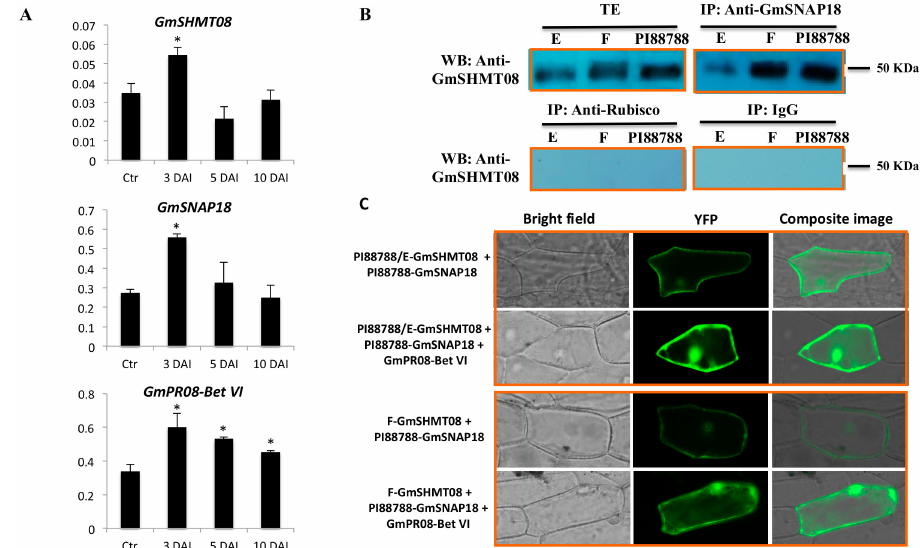
Figure 3. Expression and interaction analyses of GmSNAP18 and GmSHMT08 proteins carrying PI88788 alleles by Co-immunoprecipitation (Co-IP) and BiFC assay. ( A ) qRT-PCRanalysis of the GmSHMT08, GmSNAP18, and GmPR08-Bet VI genes in PI88788 from infected (3, 5, and 10 days) and non-infected (Ctr) root tissue with SCN HG-type 0. Expressions were normalized using Ubiquitin as reference. * Asterisks indicate significant di ff erences between samples as determined by Student’s t -test ( * p < 0.01 ). Error bars represent standard deviations. ( B ) The total protein extracts of soybean PI88788 roots were immunoprecipitated with Anti-GmSNAP18 PA. Forrest and Essex were used as positive control. Blots from the eluted fraction were probed with Anti-SHMT08. Western hybridization of the eluted fraction using both Anti-GmSHMT08 antibodies showed the presence of the GmSHMT08 and GmSNAP18 binding. IgG and Anti-Rubisco were used for Co-IP experiments as a negative control. ( C ) BiFC analysis between GmSHMT08, GmSNAP18, and / or GmPR08-Bet VI. The coding sequences of GmSNAP18 and GmSHMT08 were cloned into pSAT4-nEYFP-C1-B and pSAT4-cEYFP-C1 to generate nEYFP-SNAP18 and cEYFP-GmSHMT08 fusions, respectively. GmPR08-Bet VI was cloned into pG2RNAi2. Various combinations of cEYFP and nEYFP control fusions were co-expressed in onion epidermal cells by particle bombardment (Figure S2). Co-IP and BiFC assays indicated that GmSNAP18 and GmSHMT08 alleles from PI88788 can associate each